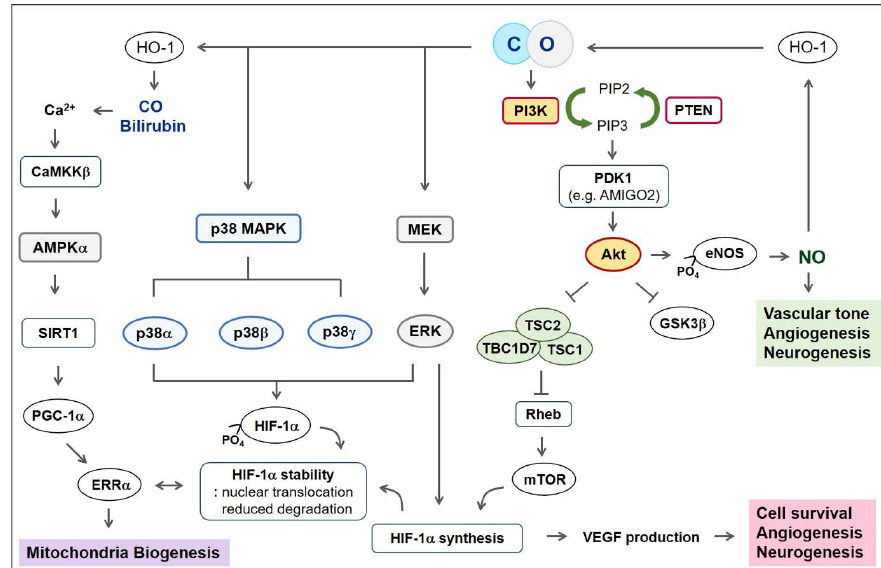
Figure 2. Schematic figures showing various signaling molecules influenced by the CO-HO-1 pathway. Firstly, CO can activate PI3K-Akt-eNOS-NO signaling. CO / NO crosstalk can lead to vessel dilation, angiogenesis and neurogenesis. NO-mediated HO-1 induction can produce CO, forming a positive feedback loop. Akt also inactivates GSK3β and the TBC1D7/TSC1/TSC2 complex. Then, activation of mTOR through inhibition of Rheb results in protein translation, such as HIF-1α. HIF-1α-mediated VEGF production and secretion induce cell survival, angiogenesis and neurogenesis. Secondly, through phosphorylation of HIF-1 α by p38 MAPK and ERK, CO may stabilize HIF-1 α resulting in its nuclear translocation and upregulation of ERR α expression. Thirdly, the combination of CO and bilirubin among HO-1 metabolites may initiate Ca 2 + entry, consequently stimulating CaMKK β